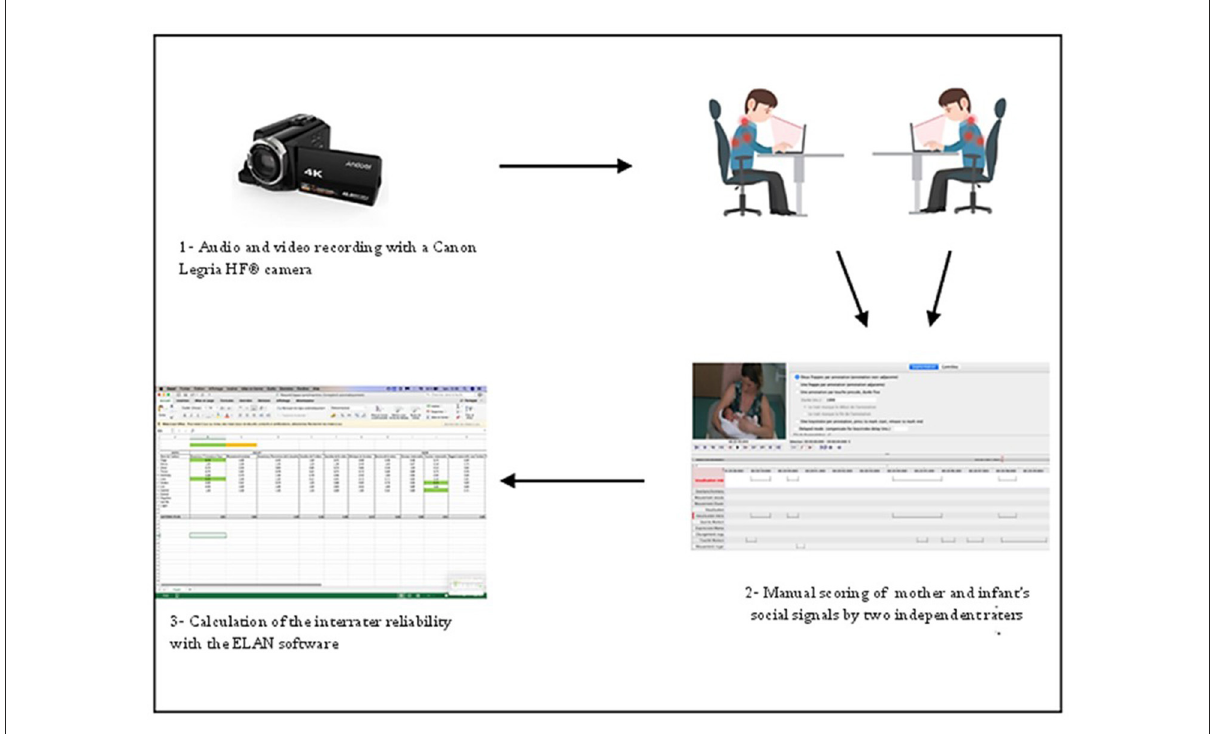
FIGURE1 Reliability study